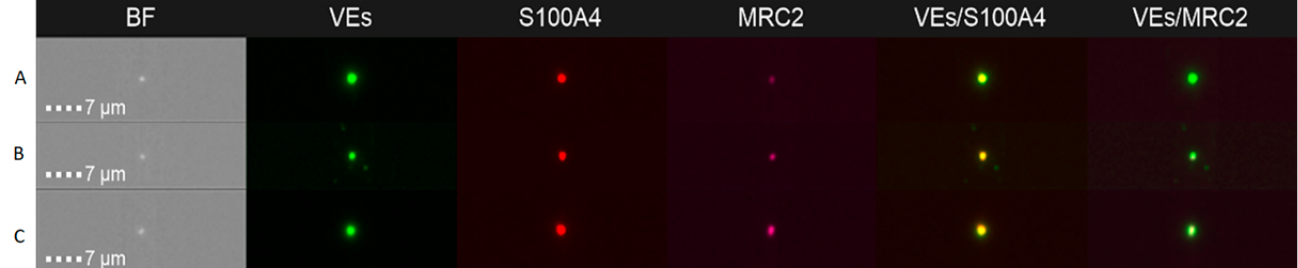
Figure 2. Image gallery of extracellular vesicles (EVs) from blood plasma of patients acquired by imaging flow cytometer. Brightfield (BF) images, Bodipy-labeled EVs (green), S100A4-AF594 (red), MRC2-Cy5 (magenta), and images corresponding to superimposed fluorescence channels (merged images) are shown. ( A ) Control; ( B ) moderate PC (ISUP ≤ 3); and ( C ) aggressive PC (ISUP > 3).